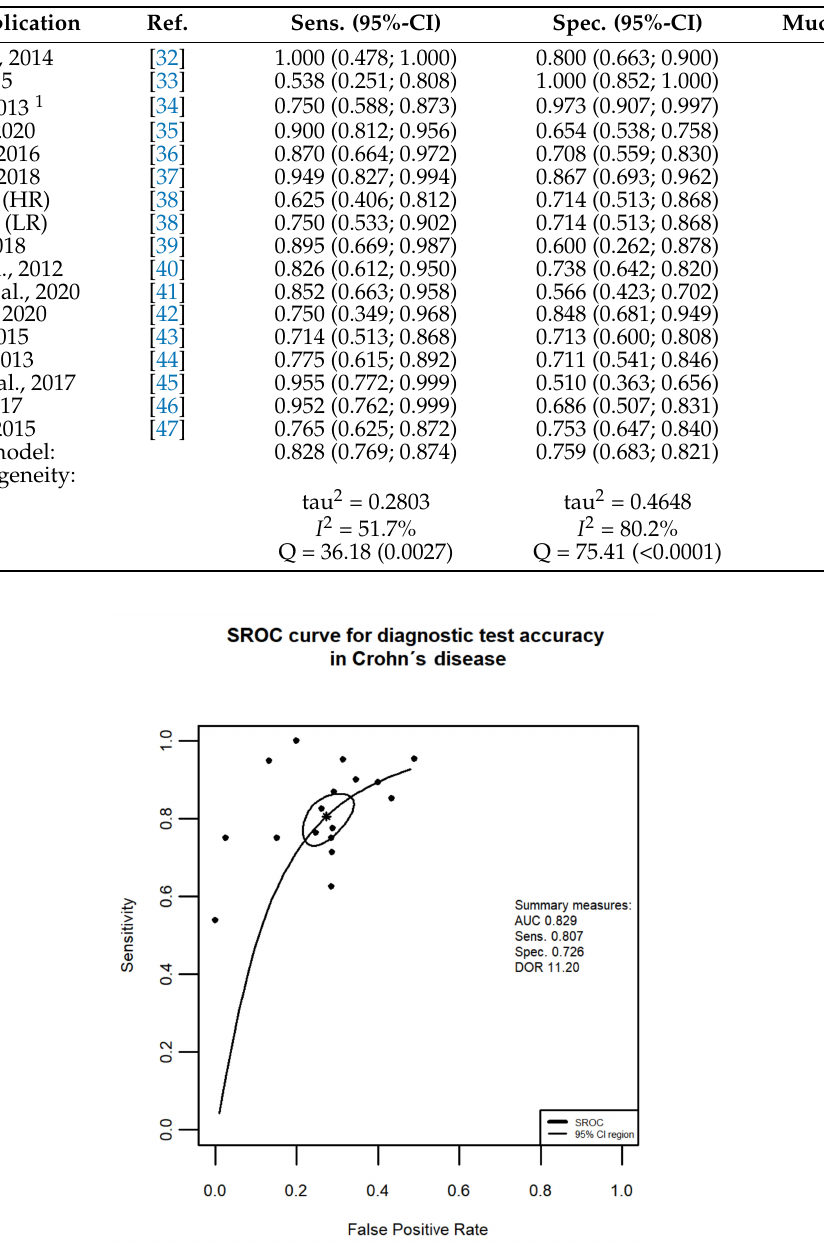
Figure 2. Summary Receiver Operating Characteristic (SROC) curve of the application of FC in the diagnosis of mucosal healing in Crohn’s disease superimposed on Sensitivity and False Positive Rate (1-Specificity) results from 17 studies. Summary Sensitivity and summary False Positive Rate are shown as a star, with the 95% CI area circled. Abbreviations: AUC, area under the curve; Sens., sensitivity; Spec., specificity; DOR, diagnostic odds ratio, CI, confidence